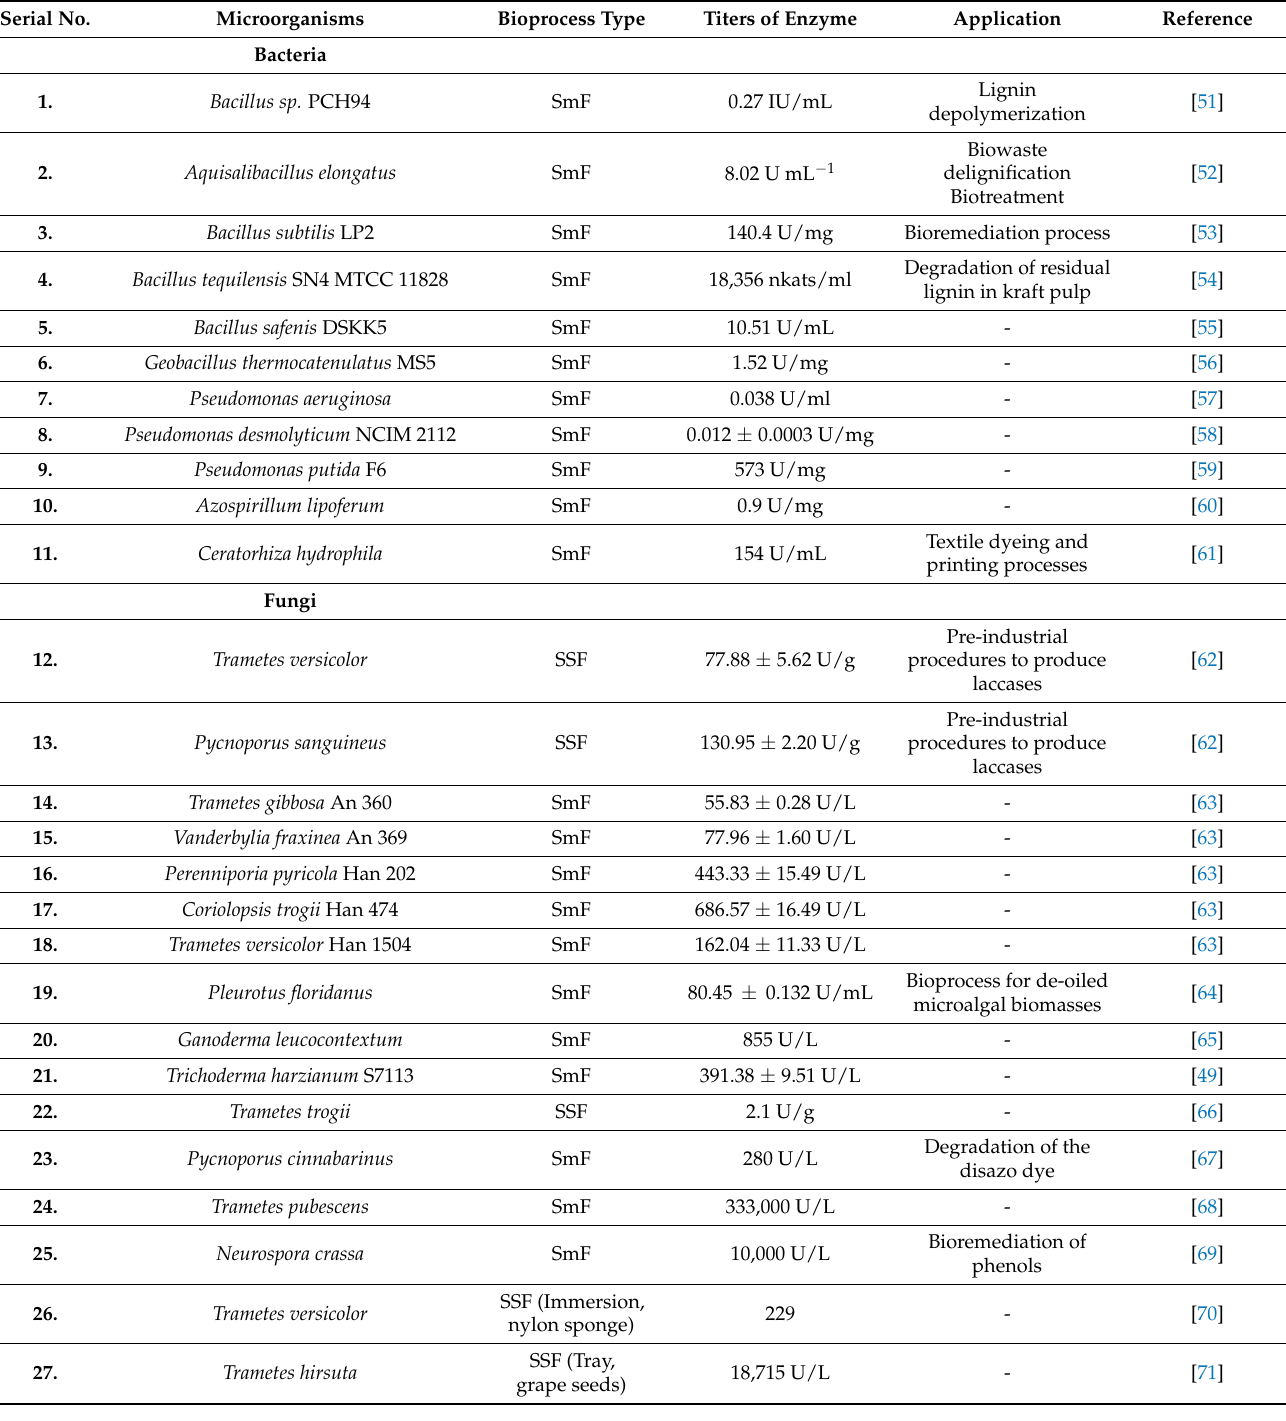
Table 2. An account of microorganisms producing laccase via different modes of